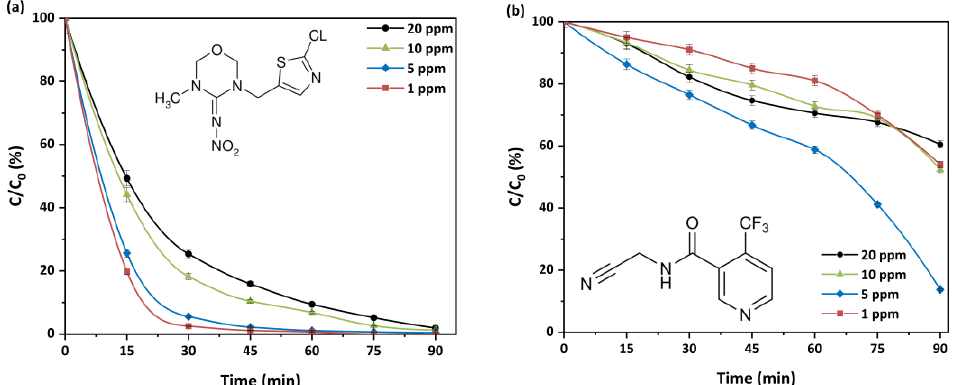
Figure 1. Degradation kinetics of photocatalytic degradation of ( a ) thiamethoxam (TMX) and ( b ) flonicamid (FND) using titania P25 at the studied concentrations (UV-A irradiation, 0.1 g/L TiO 2 , natural pH, 25 °C).